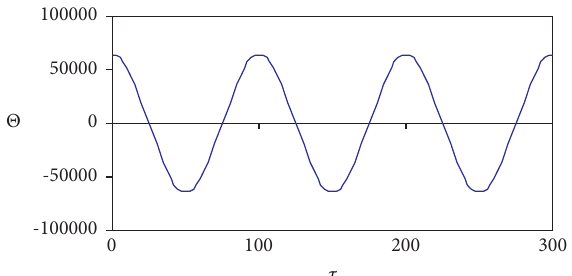
Figure 21: The analytical solution Θ for case (ii) in Section 4.2.